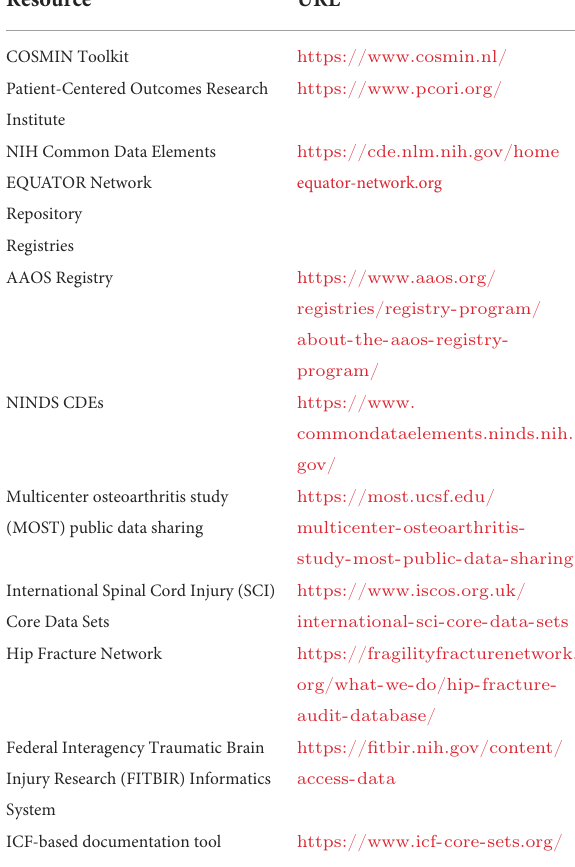
TABLE 2 Resources for using PROMs in sports medicine